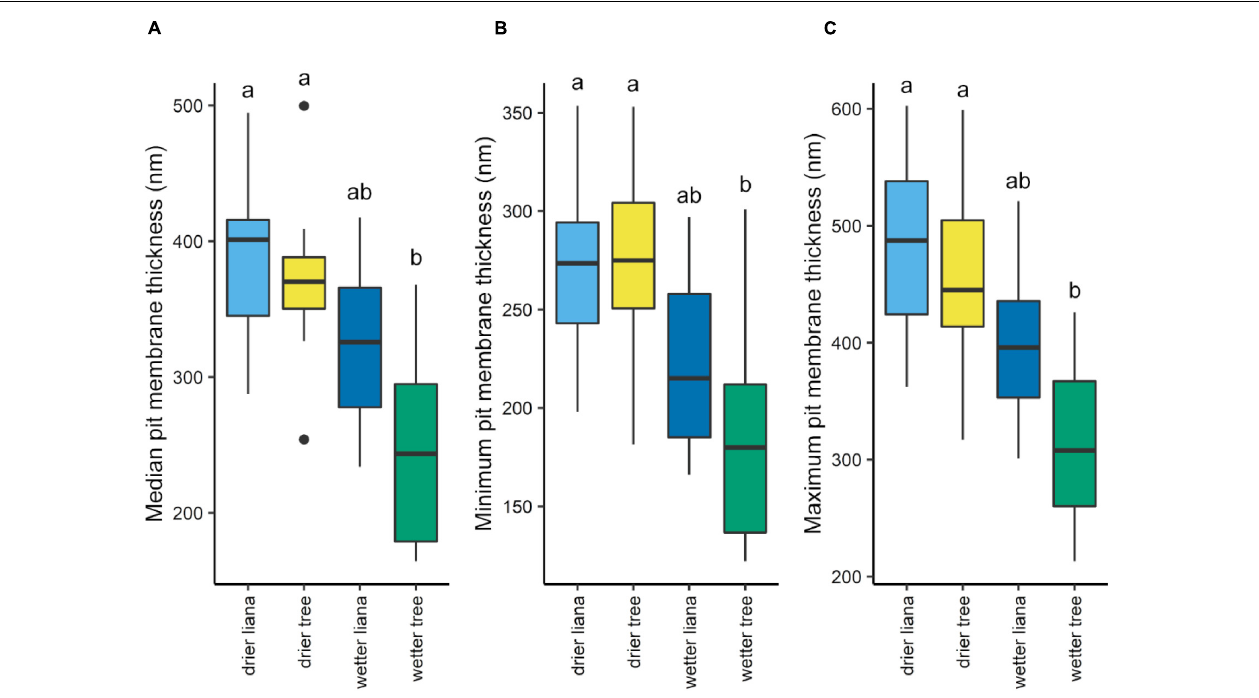
FIGURE 5 | Median (A) , minimum (B) , and maximum (C) pit membrane thickness by growth form and forest type. Letters indicate significant ( P < 0.05) differences among groups based on Tukey’s HSD tests. Box plot midlines show medians, box edges, first and third quartiles, whiskers, minima and maxima, and points,